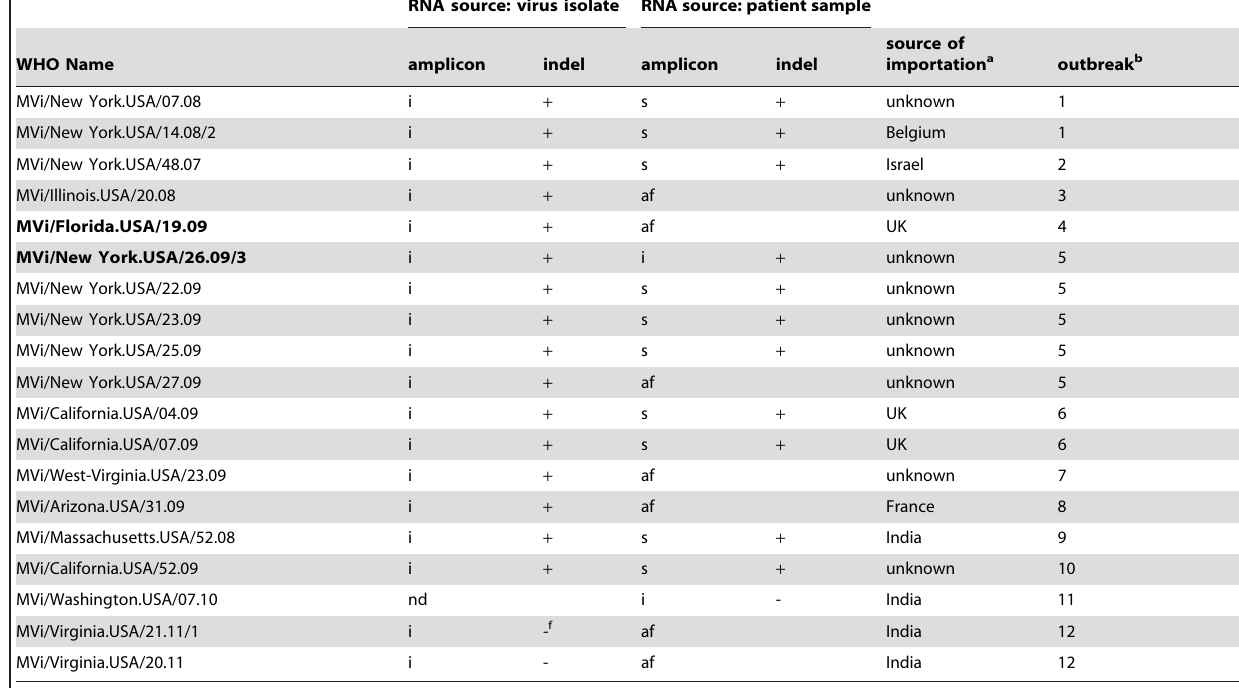
RNA source: virus isolate RNA source: patient